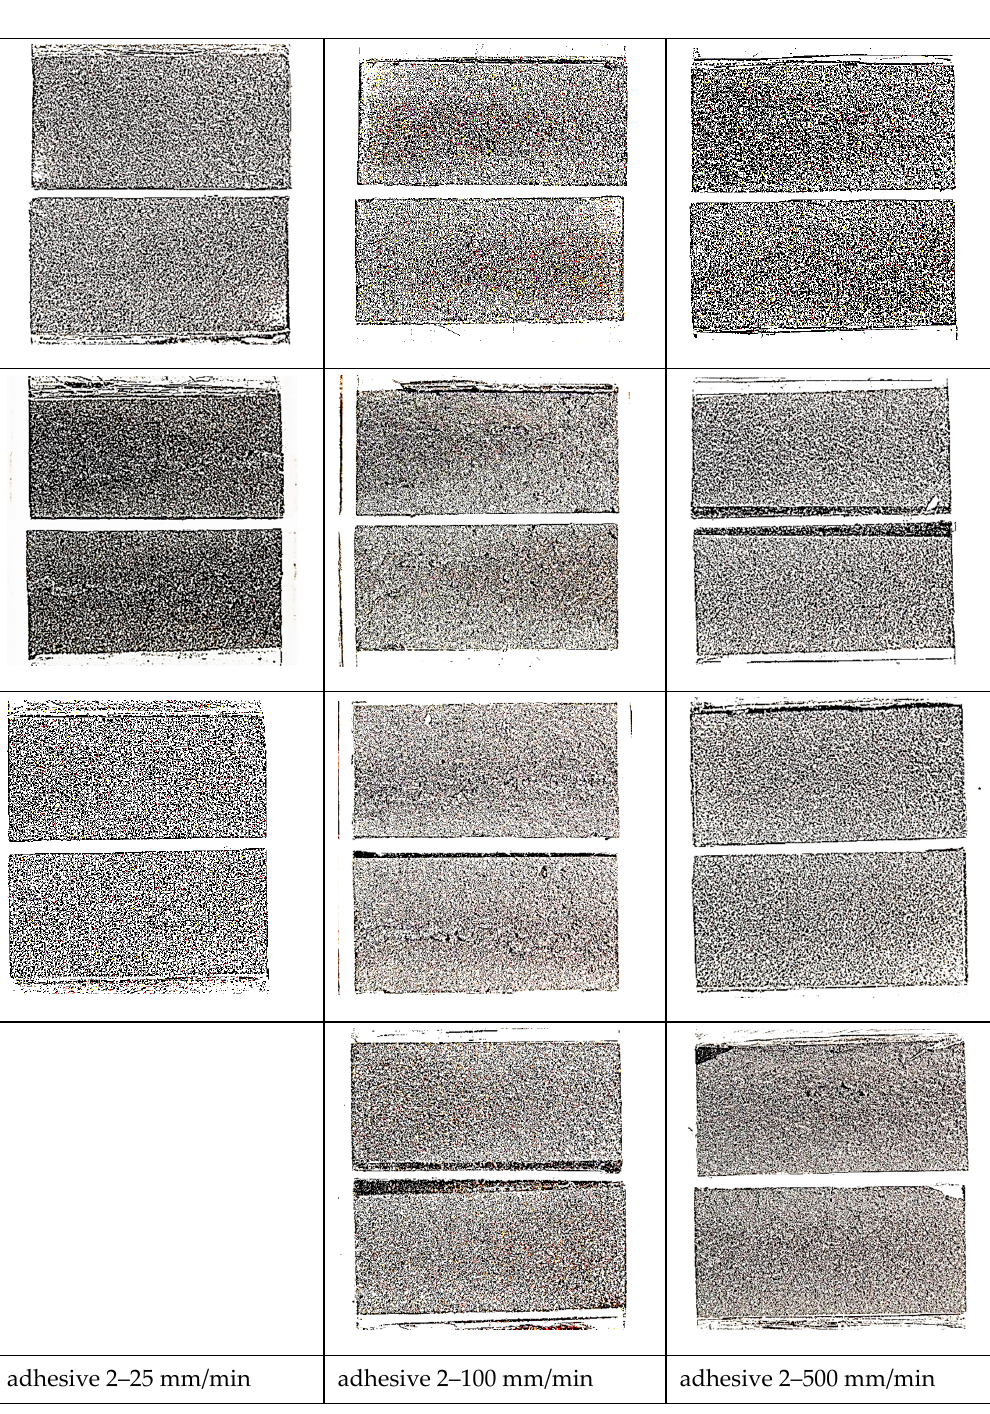
Figure 30. Failure surfaces of single lap joints bonded with adhesive 2 shown in pairs (both sides of the joint), tested at di ff erent extension